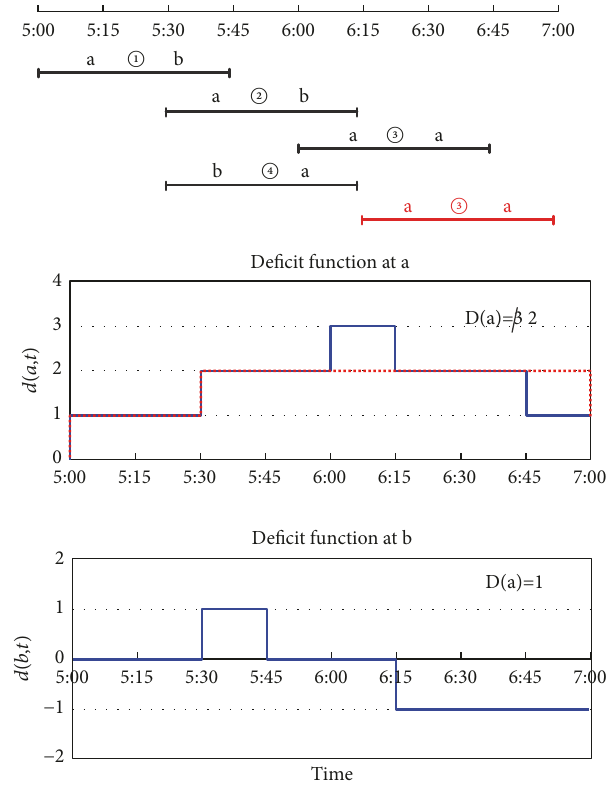
Figure 4: An example of the SDT process.